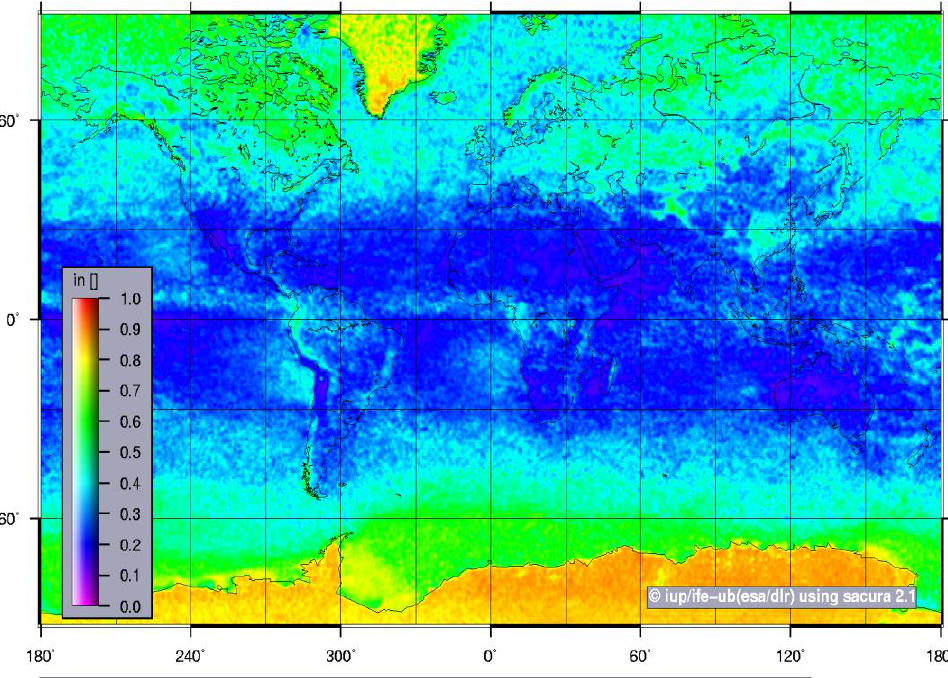
Figure 2. The reflectivity (443 nm) map for 2006. The global average value is